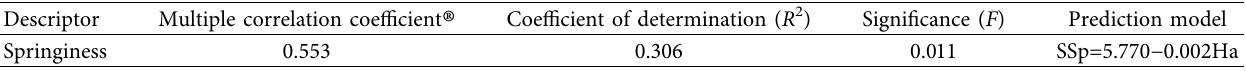
Table 6: Result of the stepwise regression for the TPA parameters as functions of sensory attributes.